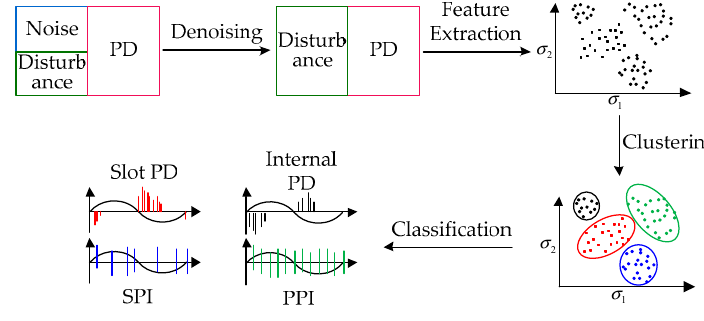
Figure 8. PD signal processing procedure [9].